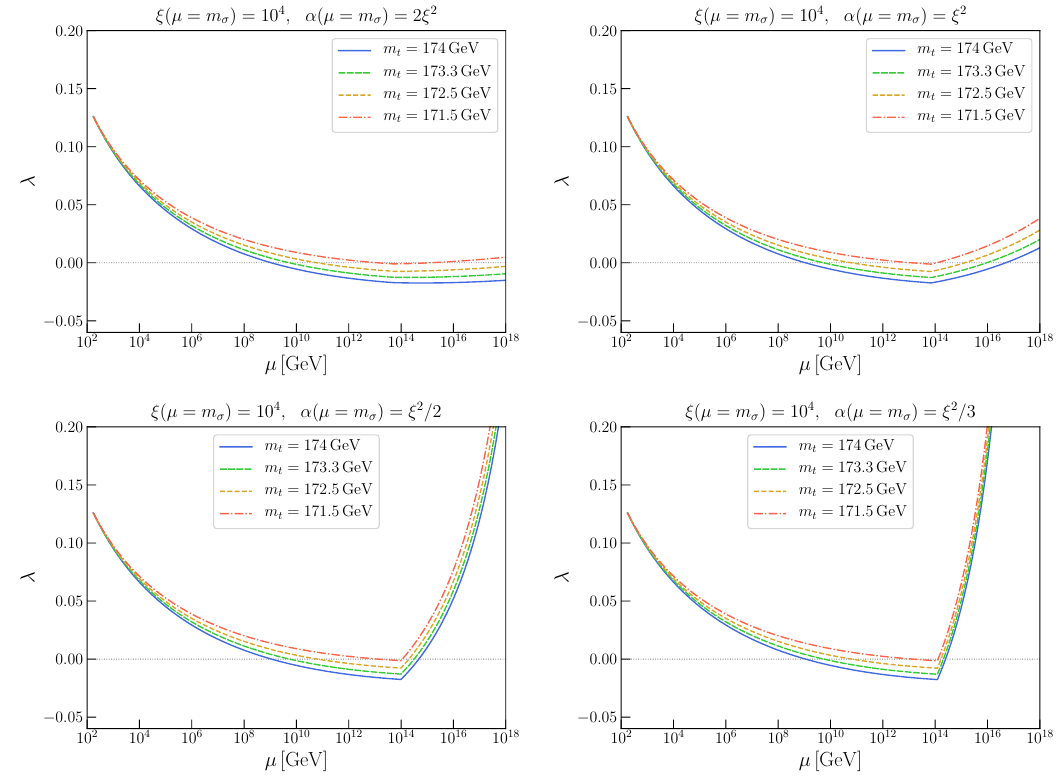
Figure 1 . The RG running of λ for different values of the ratio ξ 2 /α with ξ ( µ = m σ ) = 10 4 . The additional contribution from the scalaron makes λ positive if ξ 2 /α is large enough. A too large value of ξ 2 /α however results in a Landau pole below the Planck scale. The Higgs mass is fixed as m h = 125 . 15 GeV , and the other SM parameters are fixed according to ref. [54]. We have used the two-loop SM beta functions for m t < µ < m σ , and the beta functions of sections 2.3 and 2.4 for m σ < µ < M P